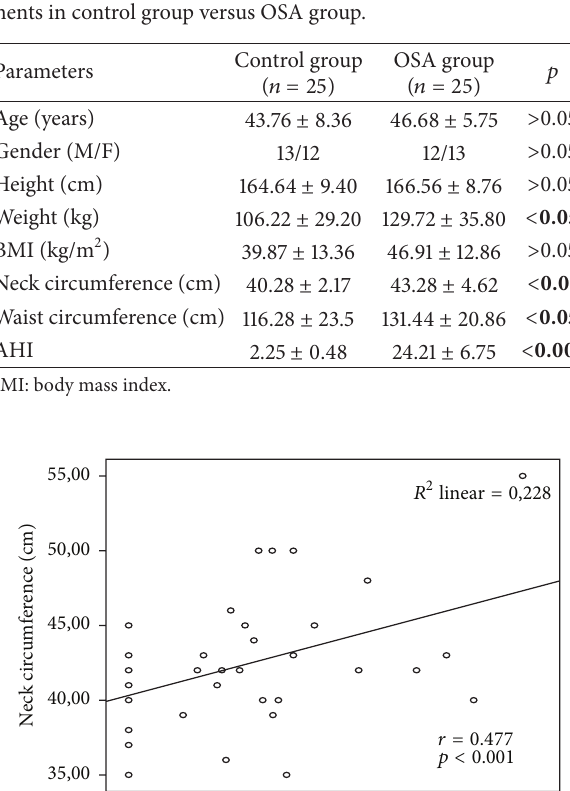
Table 2: Glucose metabolism in control group versus OSA group.